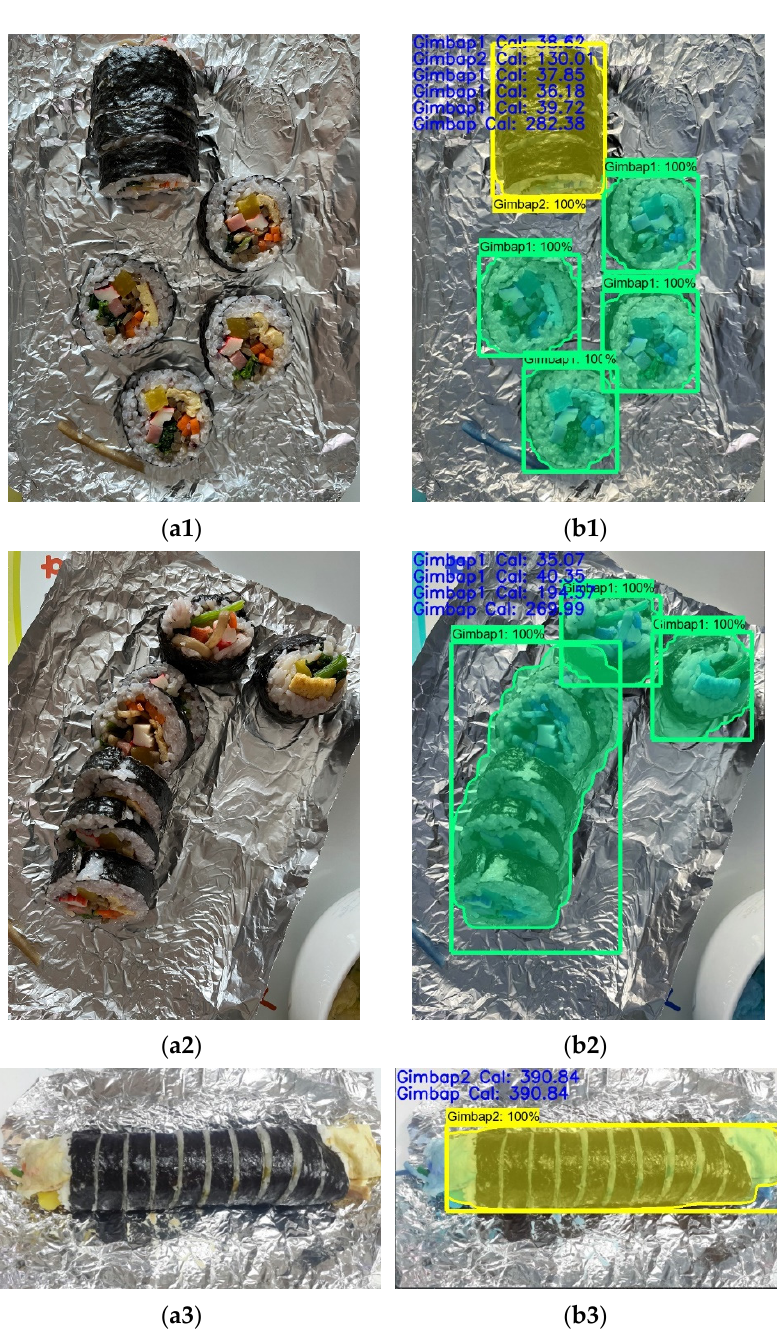
Figure 10. Calorie estimation results of test samples: ( a.1 – a.3 ) original images including Gimbap, ( b ) instance segmentation images. ( b.1 ) The Gimbap calorie of each detection is shown in the picture. The total calorie is 282.38 kcal. ( b.2 ), five pieces of Gimbap are recognized together as Gimbap1, and the calorie is 194.57 kcal. The calorie of the other two pieces of Gimbap is 35.07 kcal and 40.35 kcal, separately. The total calorie is 269.99 kcal. ( b.3 ), the calorie of the Gimbap is 390.84 kcal.